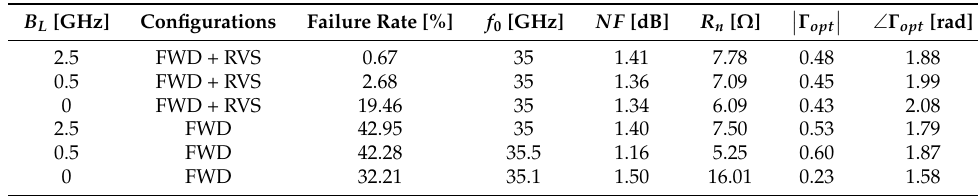
Table 1. Comparison among different extraction settings.